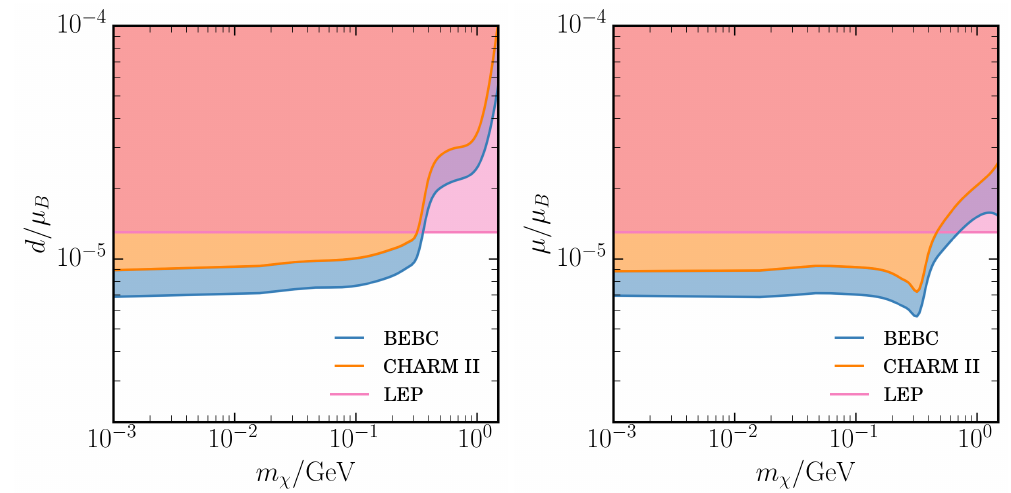
. The bounds from L3 at B